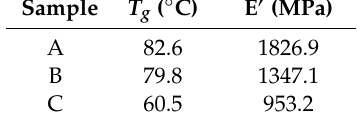
Figure 8. Dynamic mechanical analysis (DMA) curves of hybrid polymer storage modulus loss factor tan δ ( A ) and E (cid:48) ( B ). (A: 70 ◦ C 3 h 20% epoxy monomer content resin; B: 70 ◦ C 3 h 0% epoxy monomer content resin; C: 20% epoxy monomer un post-cured content resin). Table 5. E (cid:48) and T g of the UV-cured polymer and hybrid films obtained from DMA.